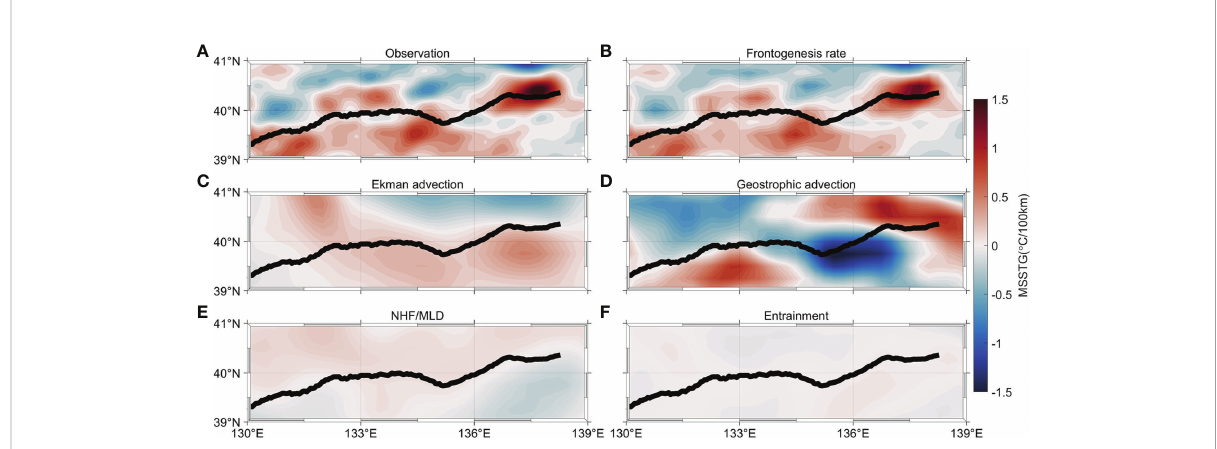
FIGURE 4 (A) The decadal change in the MSSTG between 1993 – 2002 and 2011 – 2020 (the latter minus the former; unit: °C/100km) calculated by the observation derived from the CoralTemp data. (B) The decadal change in the MSSTG calculated by the frontogenesis rate term. (C – F) Same as (B) but for the decadal change in the MSTTG calculated by (C) the Ekman advection gradient term, (D) the geostrophic advection gradient term, (E) the NHF/MLD gradient term and (F) the entrainment gradient term. Black lines indicate climatological position of the